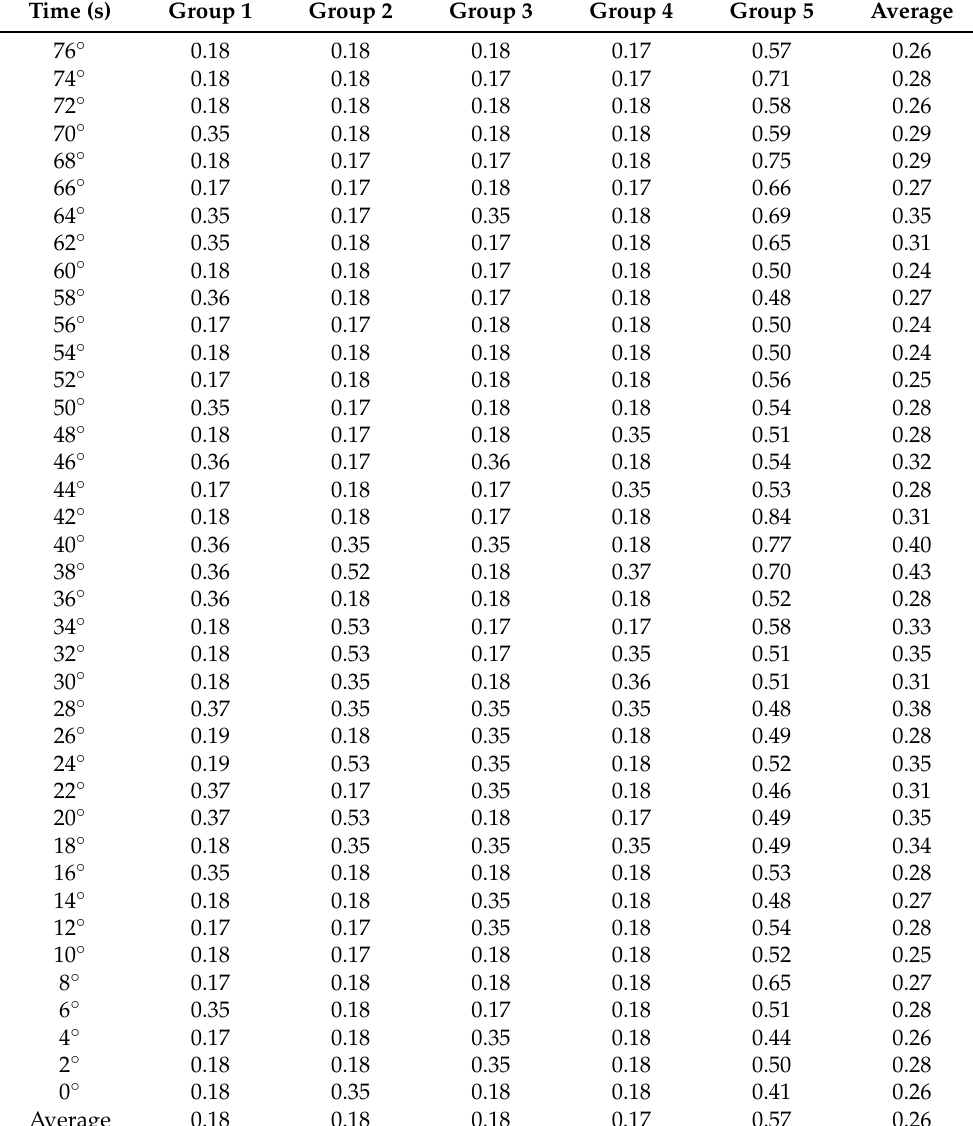
Table 8. Running time of the segmentation results obtained by Method